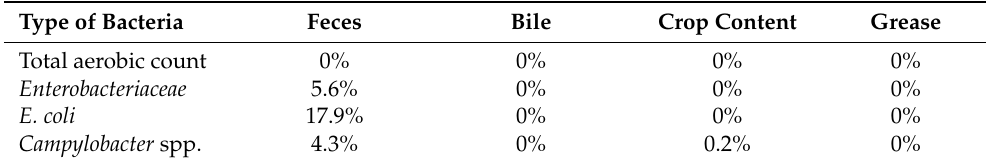
Table 5. The probability (%) that a small visible contamination results in at least a three-fold increase (calculated based on CFUx10 x ) in the total bacterial load of the average chicken carcass (1600 g). Type of Bacteria